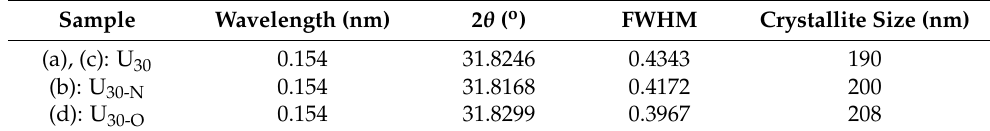
Table 1. Grain sizes of the original and additionally heat-treated sensors.